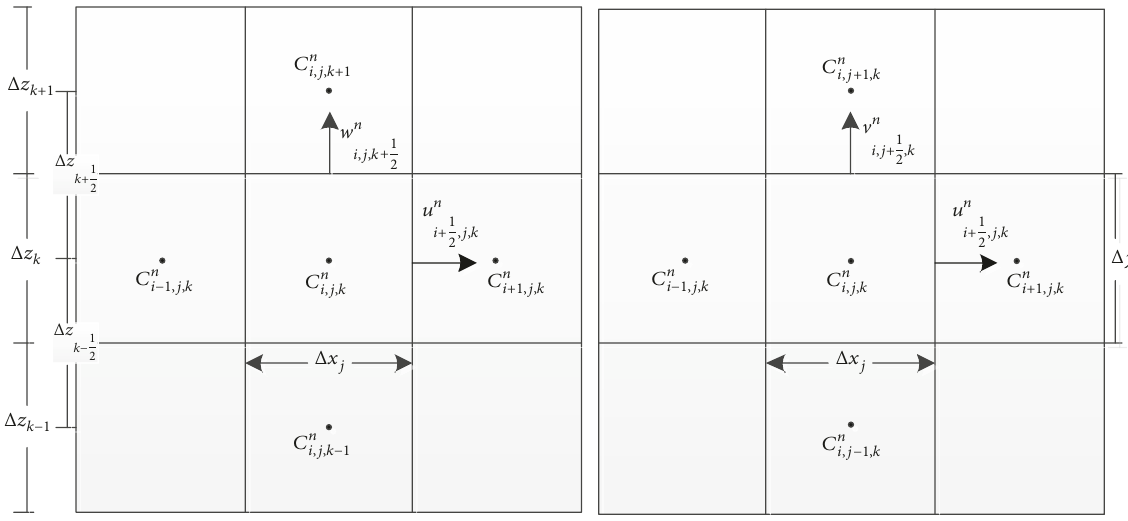
Figure 1: 𝐶 𝑛 𝑖,𝑗,𝑘 at grid center is the pollutant concentration. 𝑢 𝑛 𝑖+1/2,𝑗,𝑘 , V 𝑛 𝑖,𝑗+1/2,𝑘 , and 𝑤 𝑛 𝑖,𝑗,𝑘+1/2 are the convection velocities in the east-west, north-south, and vertical directions. Δ𝑥 𝑗 ,Δ𝑦,Δ𝑧 𝑘 and Δ𝑧